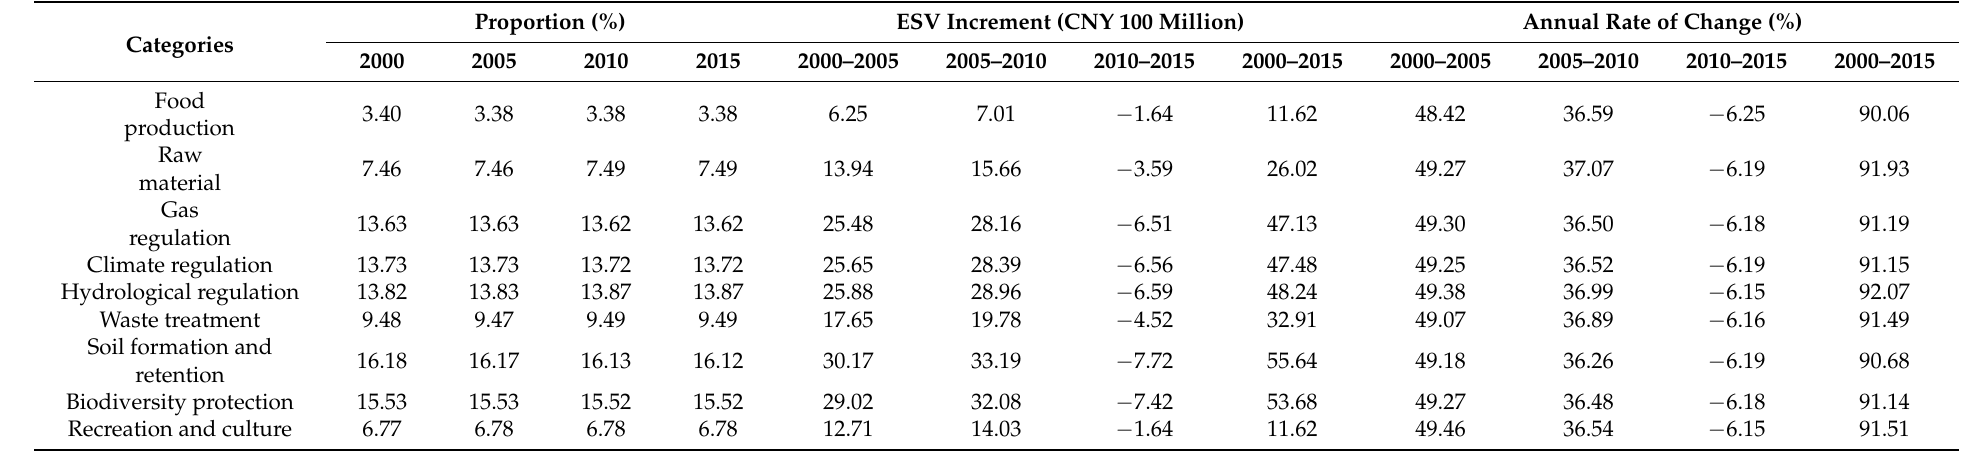
Table 7. Changes in the value of different ecosystem services in the Qinba Mountains from 2000 to